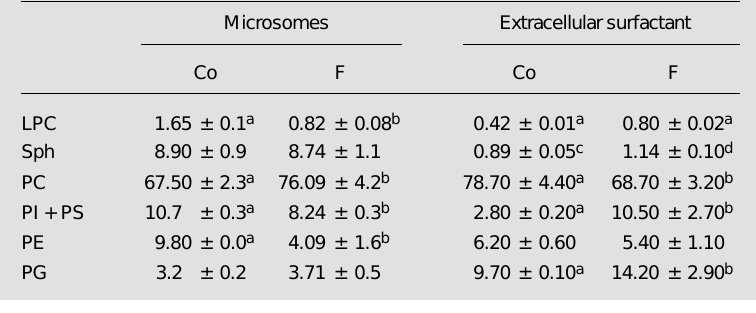
Figure 1 - Effect of surgical and pharmacological castration on male rat lung. H-E staining,